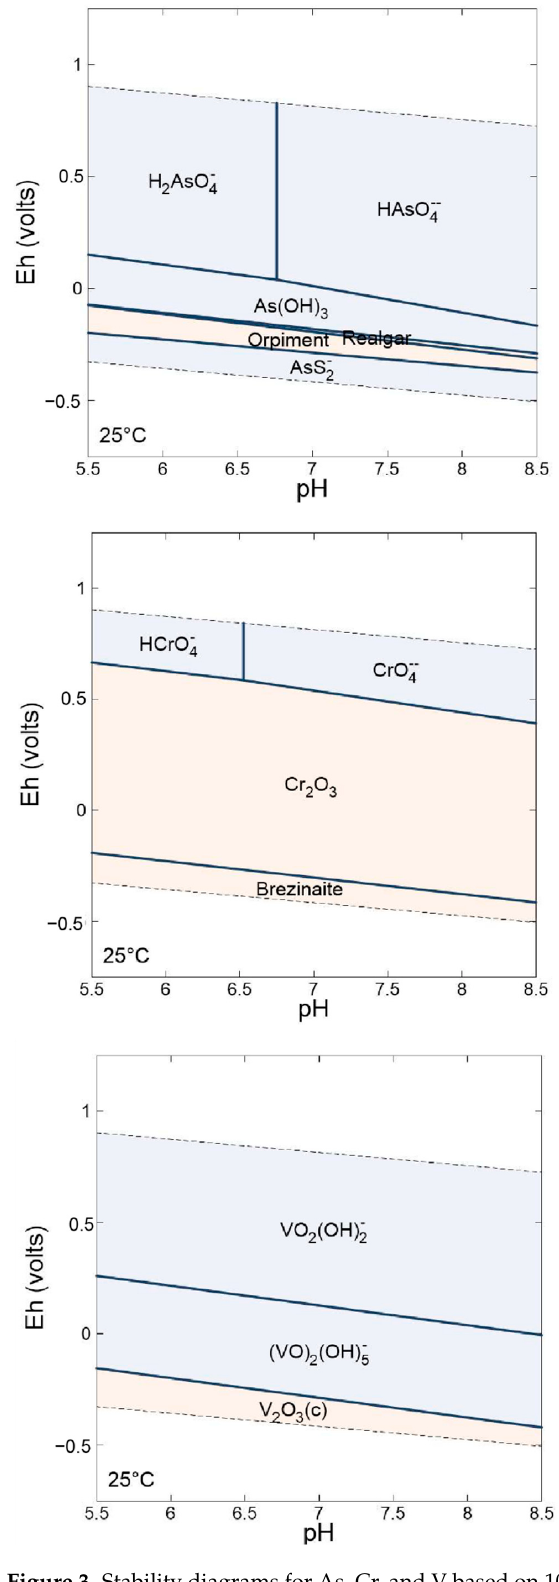
Figure 3. Stability diagrams for As, Cr, and V based on 10 µ g/L for each element, HCO 3 − and SO 4 2 − activities of 10 − 3 and 10 − 4 M using data from [6,69]. Figure constructed using the student version of the Geochemist’s